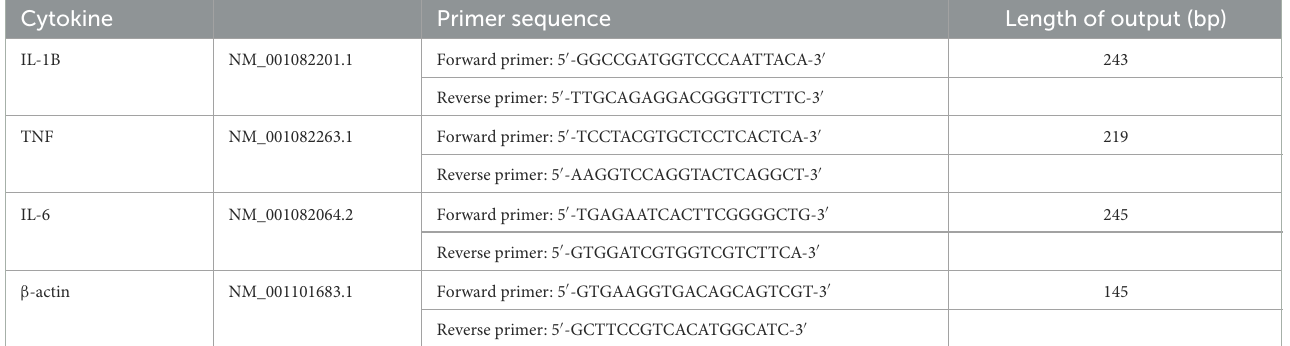
TABLE 1 Primer information. Cytokine Primer